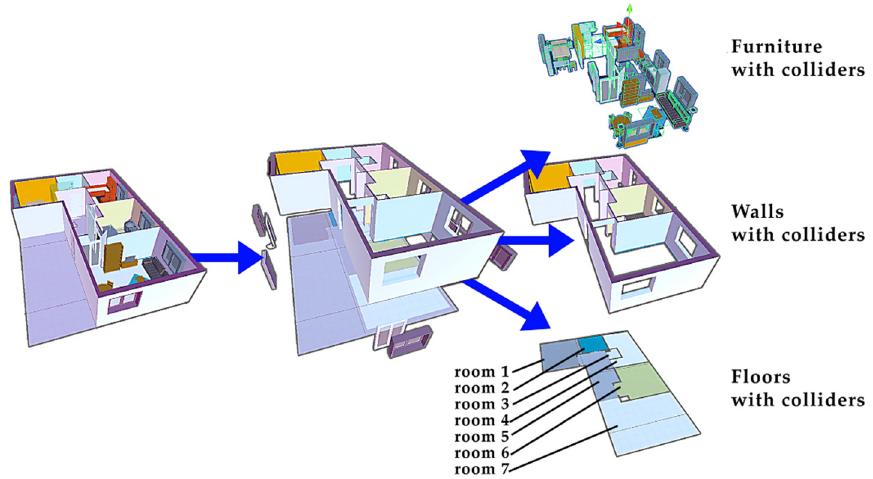
Figure 5. 3D element detection in the apartment from Figure 2d. The collider component was sepa- rately added to furniture, walls, floors, and doors.